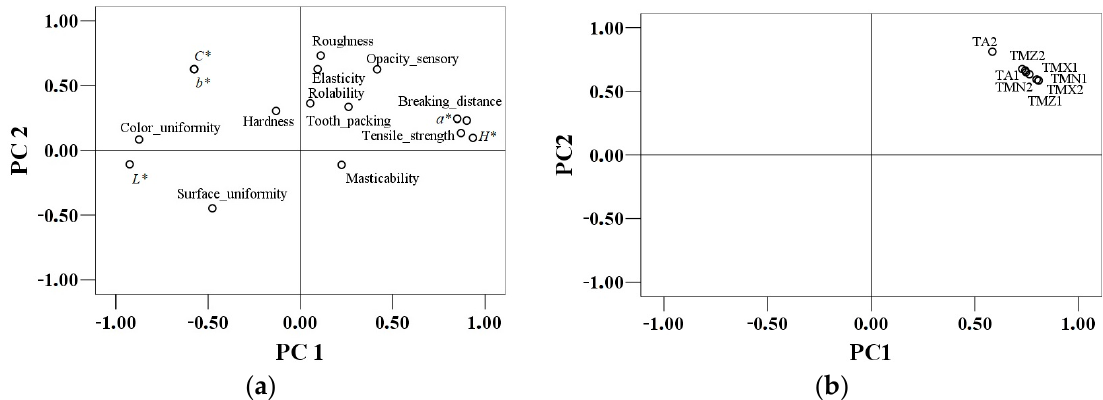
Figure 1. Principal component analysis: distribution of the physical ( L*, a* , b* , C* , H* -color parameters, tensile strength, breaking distance), textural (hardness, roughness, elasticity, masticability, tooth packing, rollability), and sensory parameters (opacity, surface uniformity, color uniformity) analyzed ( a ). Distribution of tortillas samples (TMX—tortillas from maize grains and industrialized corn flour; TMZ—tortillas from locally grinded and nixtamalized maize grains only; TMN—tortillas from industrialized maize flour; and TA—artisanal hand-made tortillas) in the function of the analyzed parameters ( b